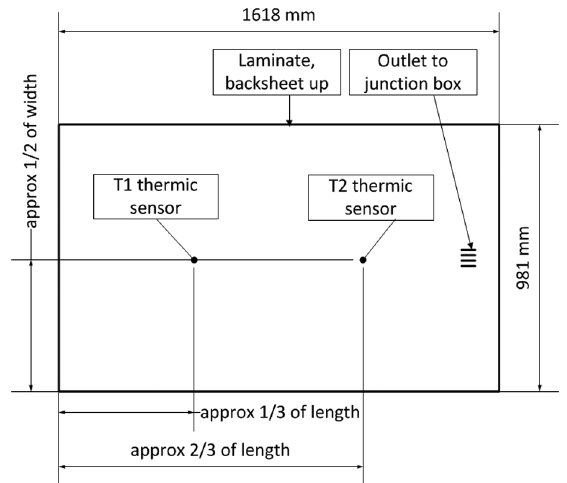
Fig. 3. Schematic representation of experimental setup.